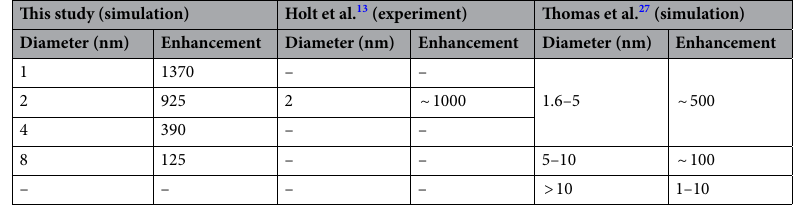
Table 2. Comparison for flow enhancement of water in